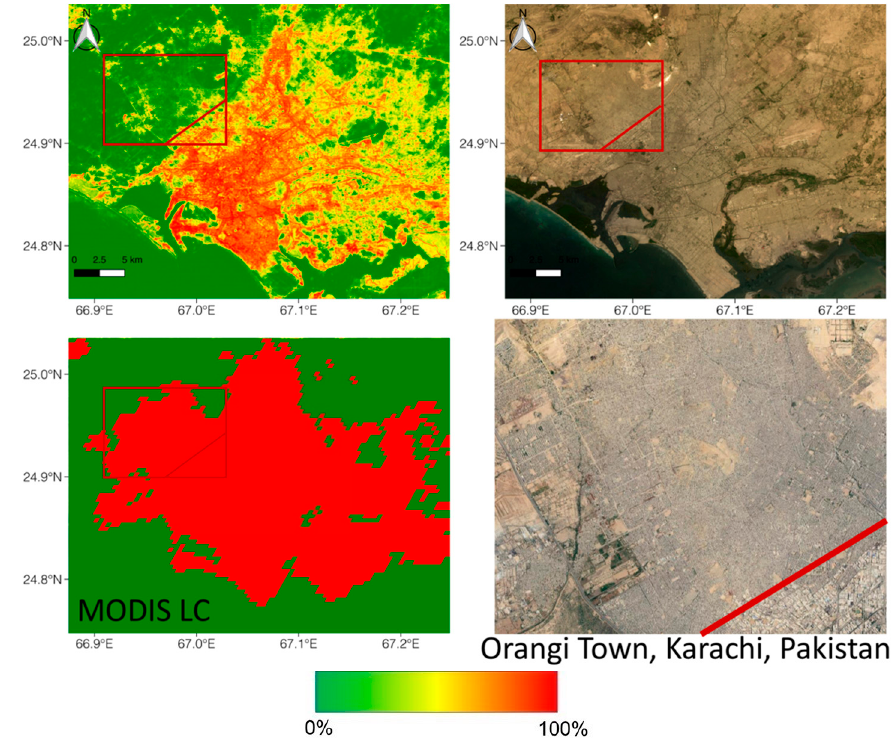
Figure 10. The Landsat-8 true color composite image and corresponding impervious surface map in the year 2019 (first row) for the Karachi, Pakistan. Red line separates the marked high impervious region from the biggest slum named Orangi Town (red rectangle) shown in the high resolution satellite image in Google Map. The MODIS land cover type classification of urban and built-up lands of at least 30% impervious surface area are marked by the red region (second row left). (Source: NASA Land Processes Distributed Active Archive Center: https://lpdaac.usgs.gov/products/mcd12q1v006).